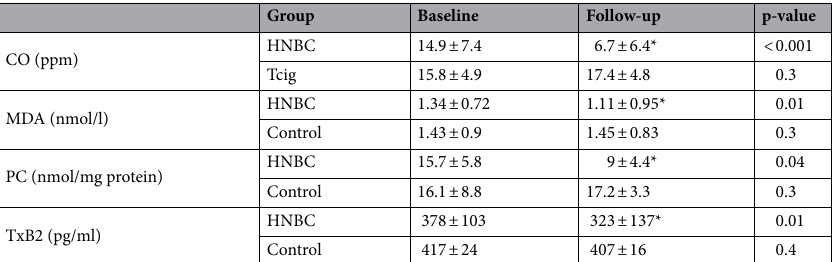
Table 4. Progression of exposure to CO, oxidative stress burden, and platelet activation after 1 month of switching from tobacco cigarette smoking to heat-not-burn product puffing. *p < 0.05 for interaction with group, derived from post hoc analysis by ANOVA. CO carbon monoxide, MDA malondialdehyde, PC protein carbonyls, TxB2 thromboxane B2values are mean ±